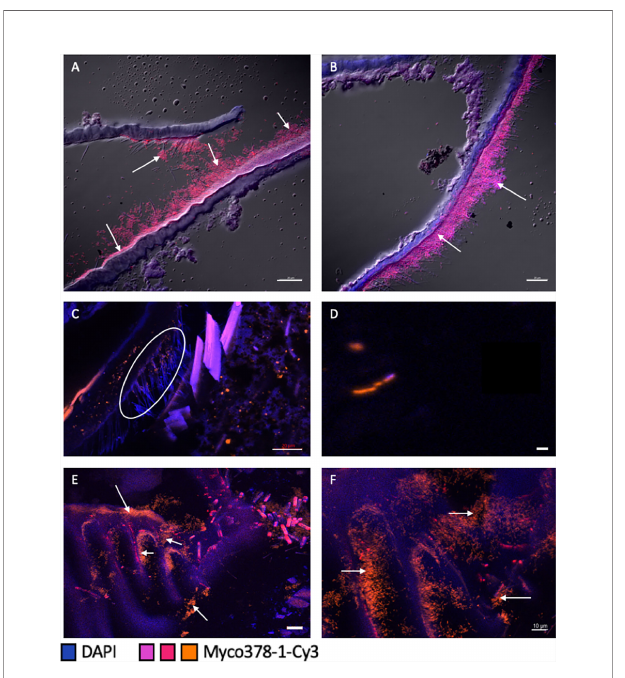
FIGURE 4 | Presence of Mycoplasmatales in the foregut of R. exoculata and R. chacei adults. (A – D) represent sections through the foregut [ œ sophagus for (A, B) , pyloric chamber for (C, D) ] of a R. exoculata adult hybridized with Myco378-1-Cy3 (pink in (A, B) or orange in (C, D) . Tissue cell nuclei are labeled with DAPI (blue). Formamide concentration in hybridization buffer was 45% (A – D) . Images (A – D) were taken with Apotome ® , and DIC for (A, B) . The white circle (C) highlights the Mycoplasmatales hidden by the setae. (E, F) represent sections through the foregut (pyloric chamber) of a R. chacei adult hybridized with Myco378-1-Cy3 (orange). Tissue cell nuclei are labeled with DAPI (blue). White arrows are targeting some Mycoplasmatales observed on the different structures. Formamide concentration in hybridization buffer was 45%. Pictures (E, F) were taken with Apotome ® . Scale bars = 20 µm (A – C, E) ; Scale bar = 1 µm (D) ; Scale bar = 10 µm (F) .